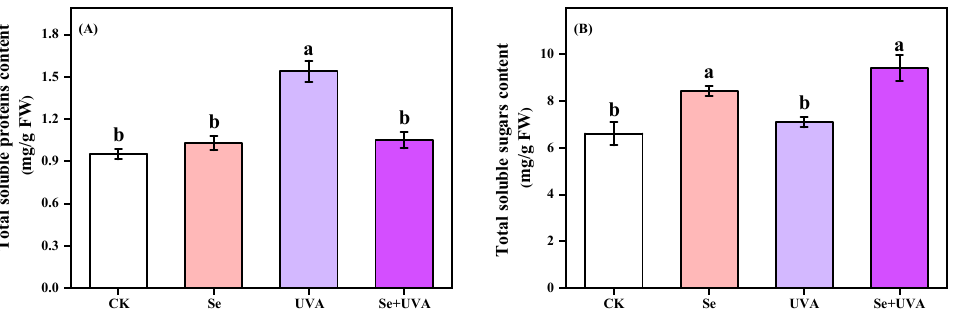
Figure 3. The contents of total soluble proteins ( A ) and total soluble sugars ( B ) in broccoli microgreens under Se (100 µ mol/L Na 2 SeO 3 ), UVA (40 µ mol/m 2 /s), and combined treatments. The vertical bars indicated standard errors, n = 3. Different lower-case letters above the bars indicated significant differences between treatments by Duncan’s multiple range test at a level of 0.05. Table 3. The interaction effects of Se and UVA on primary metabolite content of broccoli microgreens.